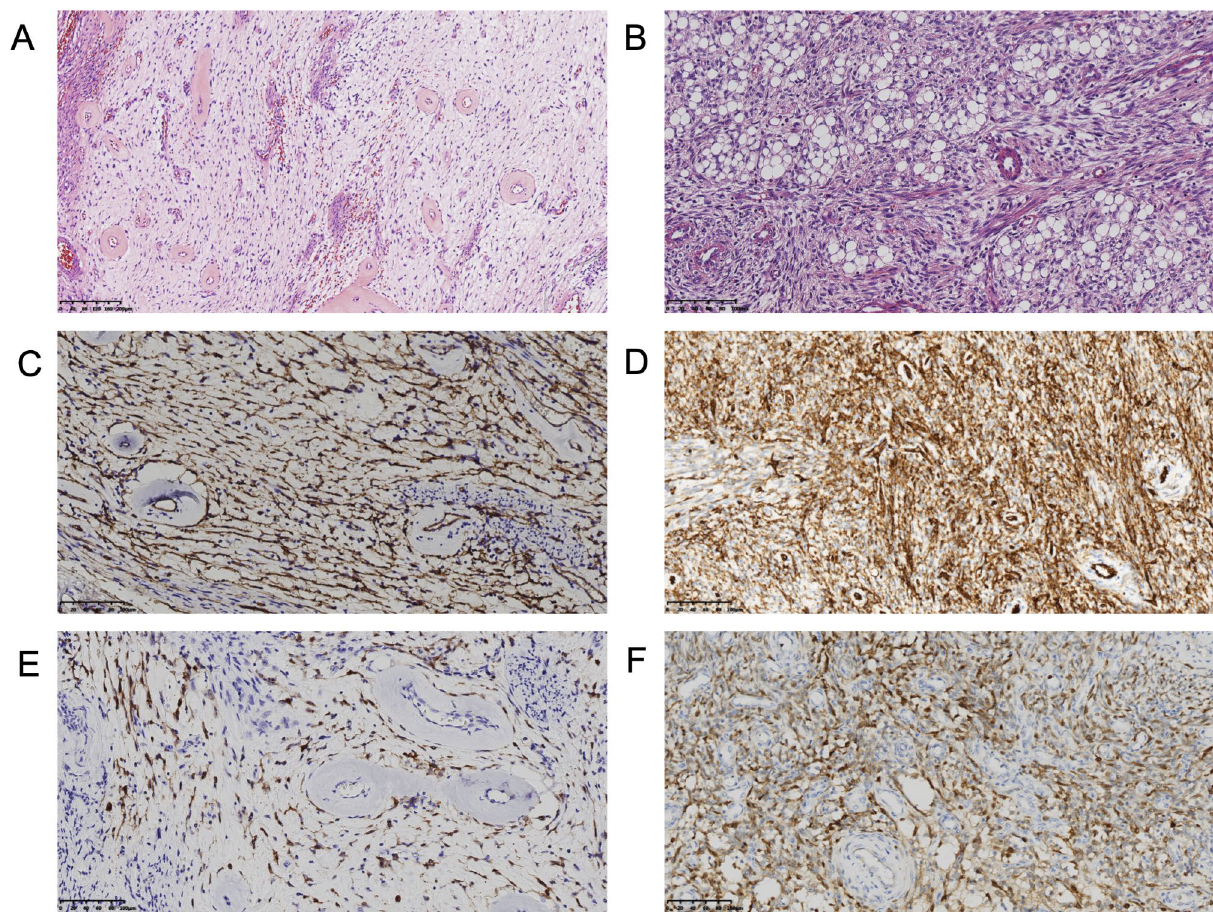
Fig. 1 Histologic and immunohistochemical features of RAF1 -rearranged tumors. A, Neurofibroma like tumor in a 30-year-old male showing slatternly arranged short spindle cells with striking perivascular rings of collagen (case1 ; ×20). B, LSFT -like tumor in a 15-year-old male showing diffusely arranged spindle cells without obvious atypia and mitotic figures (case 2; ×20). C, E, Immunohistochemical studies showing diffuse S100 and CD34 positivity (case1 ; ×20). D, F, Immunohistochemically, the tumor cells showed diffuse expression of S100 and CD34 (case 2;